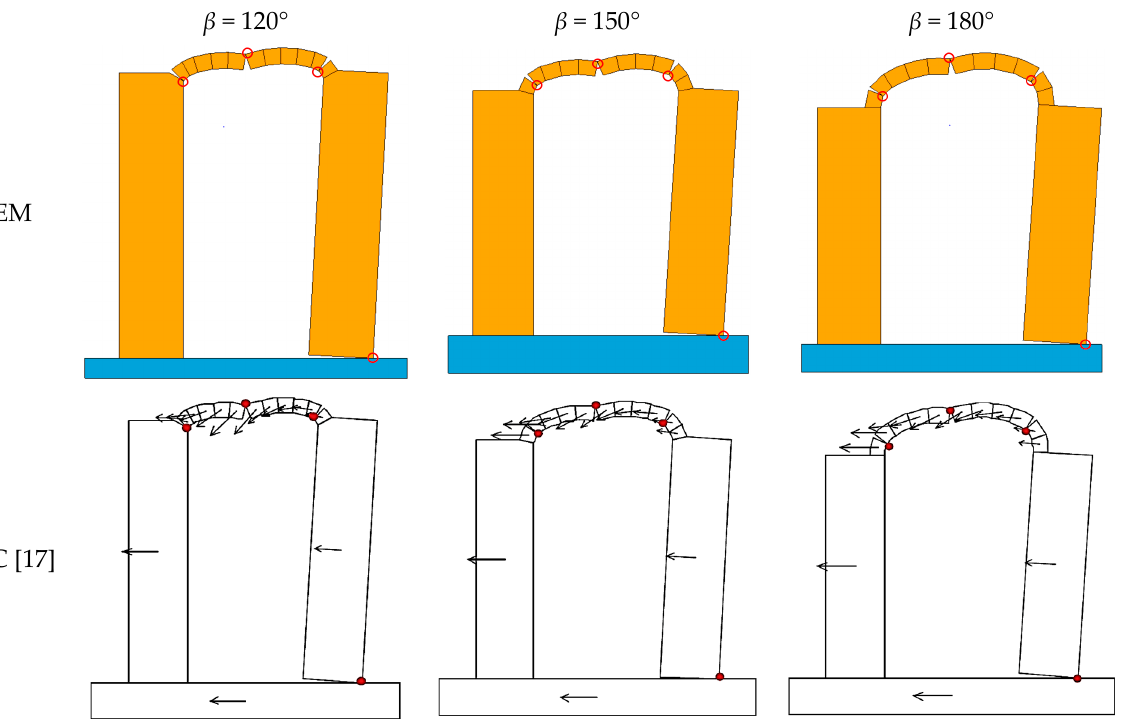
Figure 12. Failure modes of buttressed basket-handle masonry arches.